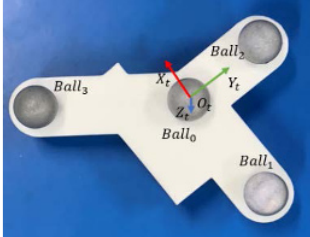
Fig. 2. Target ball number and coordinate system establishment on target ball positioning